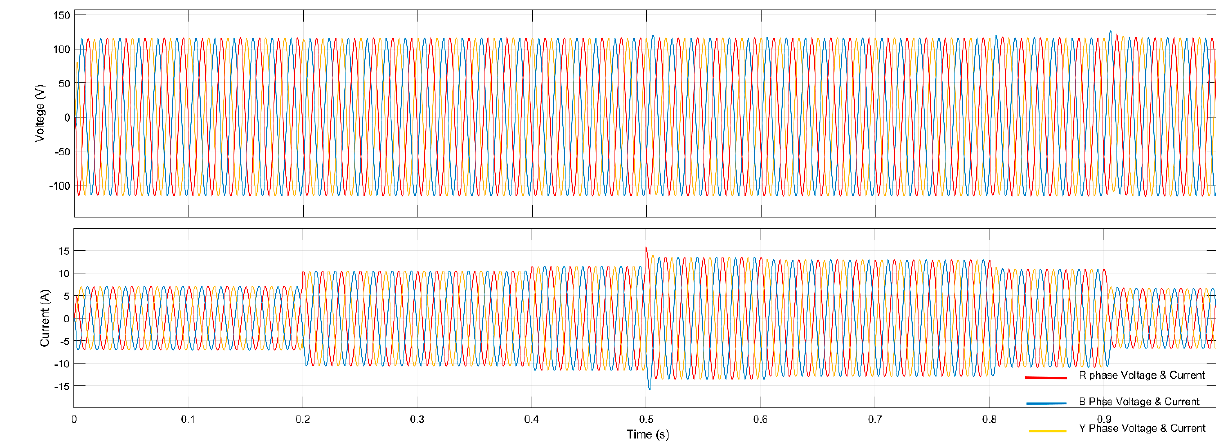
Figure 9. Load vs. Source power.